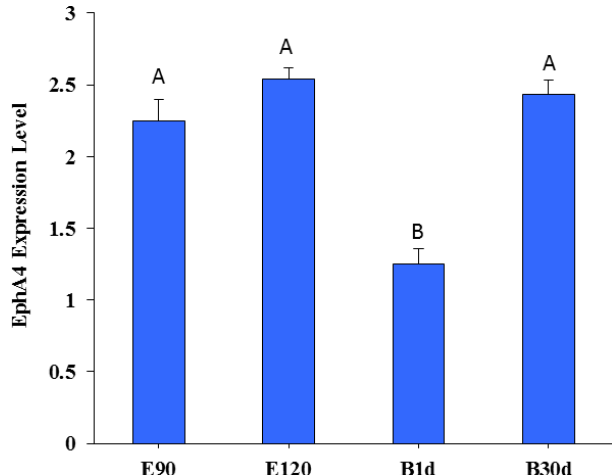
Figure 3. The relative expression level of EPHA4 in skin of fine- wool sheep at different developmental